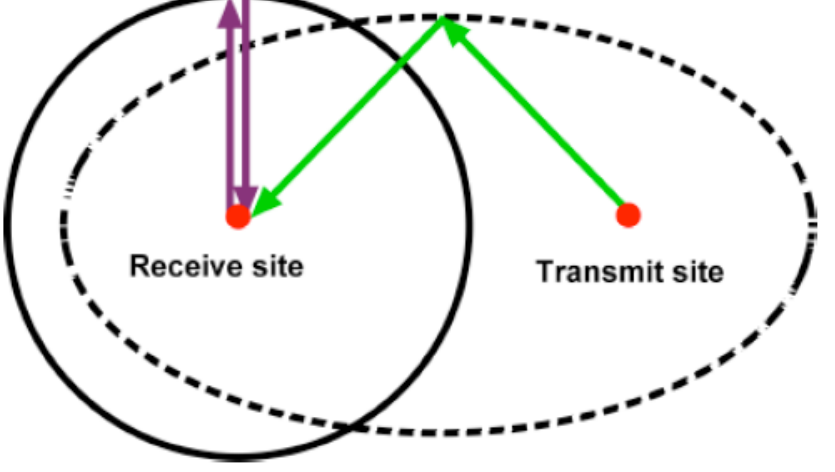
Figure 1. Schematic diagram of a bistatic radar configuration. Radar at transmit site is a transmitter only. Radar at the receive site receives bistatic echo (green) from an elliptical range contour. It also transmits and receives backscatter echo (purple) from a circular range